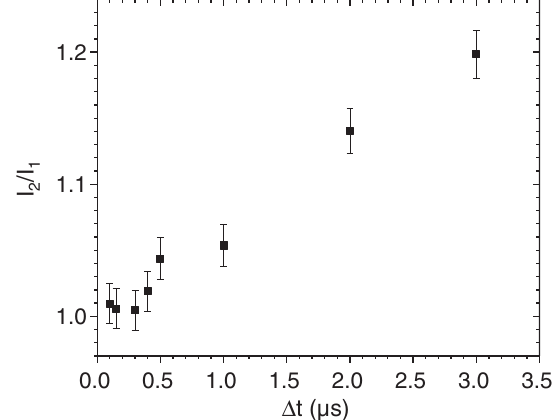
FIG. 10. Ratio of the current extracted for the second pulse I 2 to the current extracted for the first pulse I 1